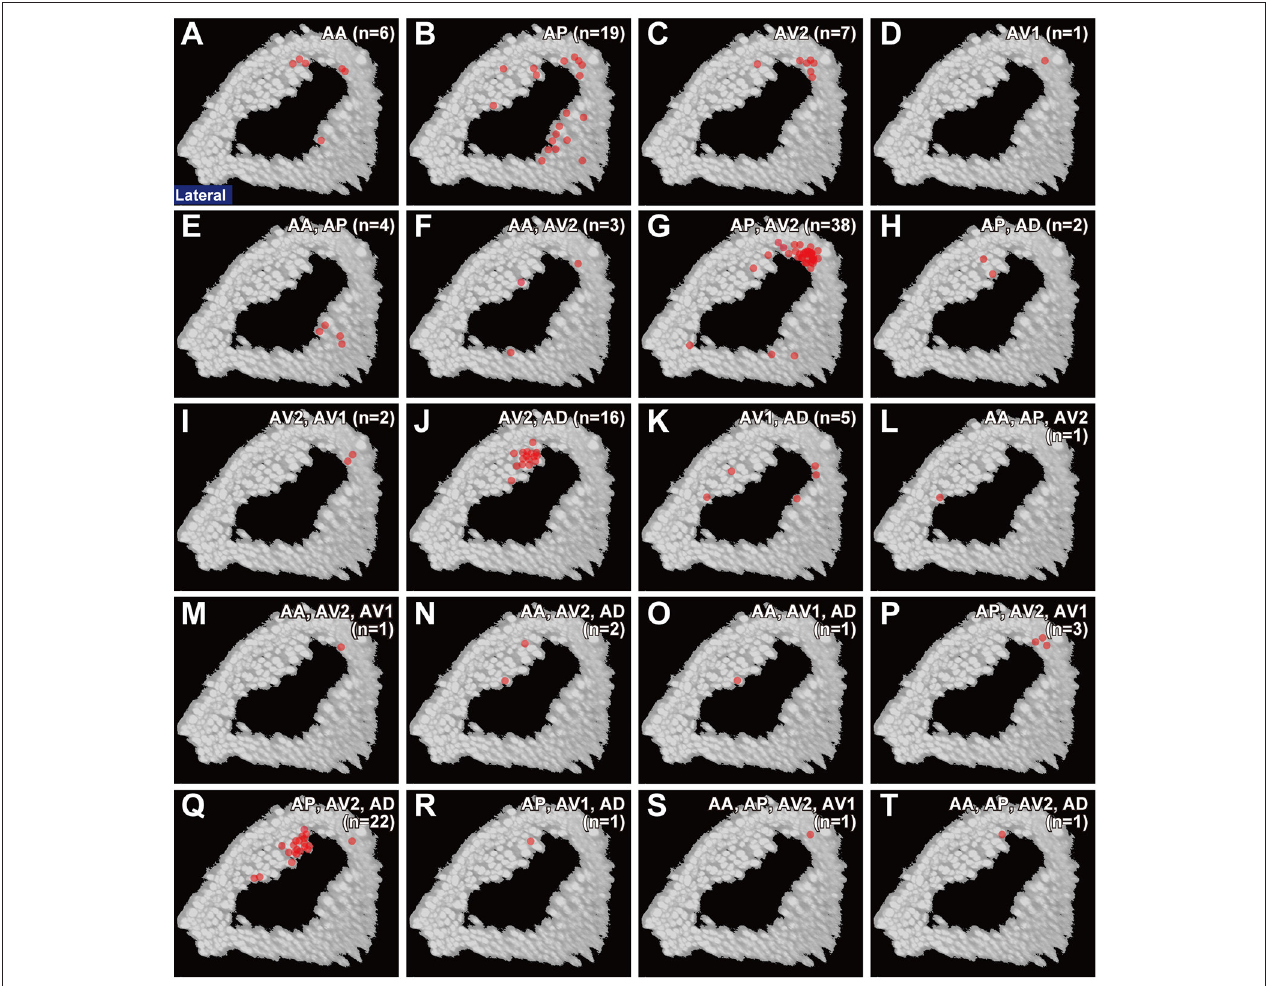
FIGURE 5 | Distribution of cell bodies. Red dots in each panel indicates the location of cell bodies of JO-A neurons that project to a single subarea (A–D) and two or more subareas (E–T) in the AMMC zone A. Target subareas are shown at the upper-right of each panel. Number of samples analyzed at the single-neuron level is shown in